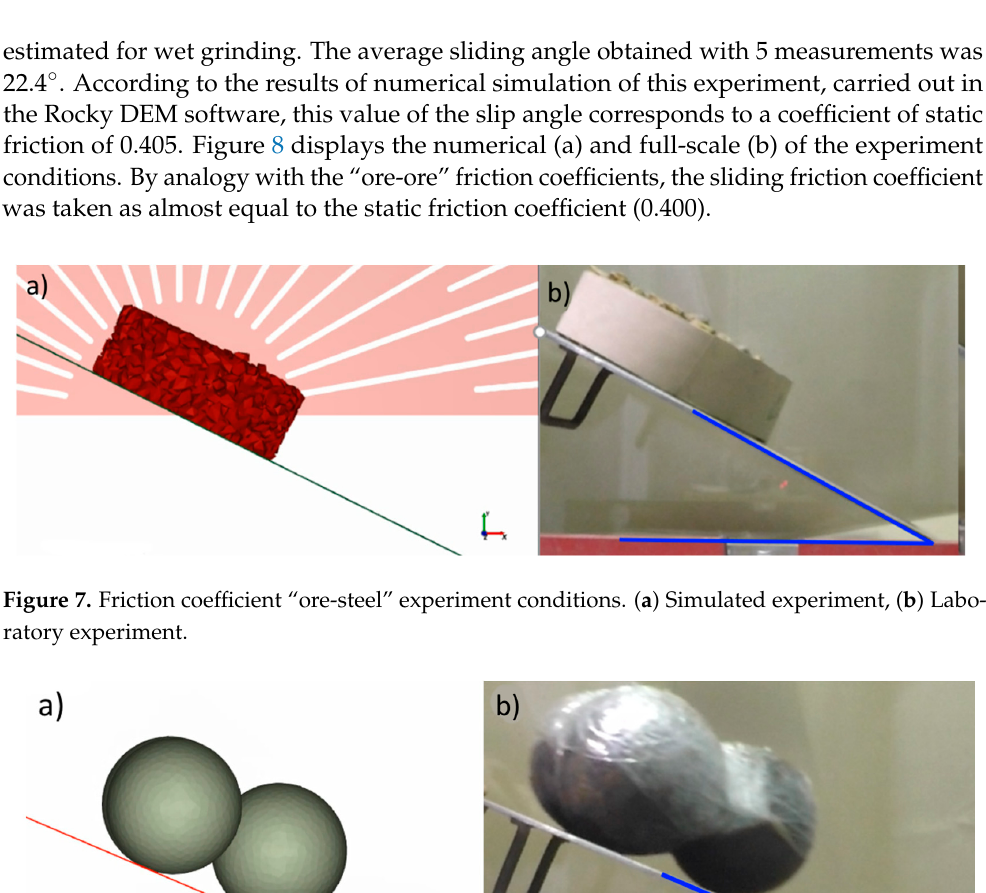
Figure 6. Two images from a series of numerical experiments to determine the influence of the dynamic friction coefficient between ore particles on the overall dynamics of the material in the rotating drum.